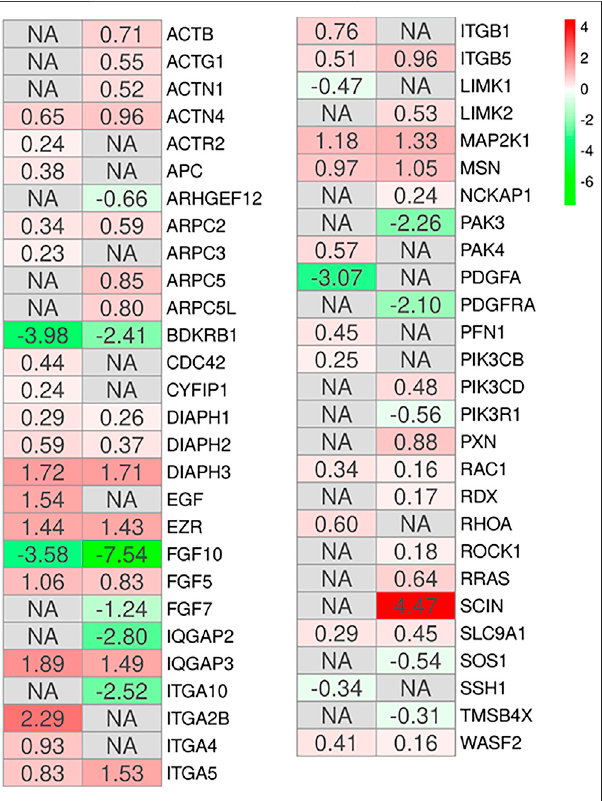
FIGURE 4 | Heatmap of genes involved in the gene ontology term “ Epithelium development ” and observed in the KEGG pathways “ Regulation ofactincytoskeleton, ”“ Focaladhesion ” or “ PI3K-Aktsignalingpathway ” inthe comparison of MSCs-lung-Normoxia against MSCs-lung-Hypoxia (left column of each comparison) or MSCs-CPAM-Normoxia against MSCs- CPAM-Hypoxia (right column of each comparison). The green scale is related to downregulated genes whereas the red palette represents upregulated ones. NA value is put when the difference is not statistically relevant in the comparison. All fold changes are rounded to the second decimal